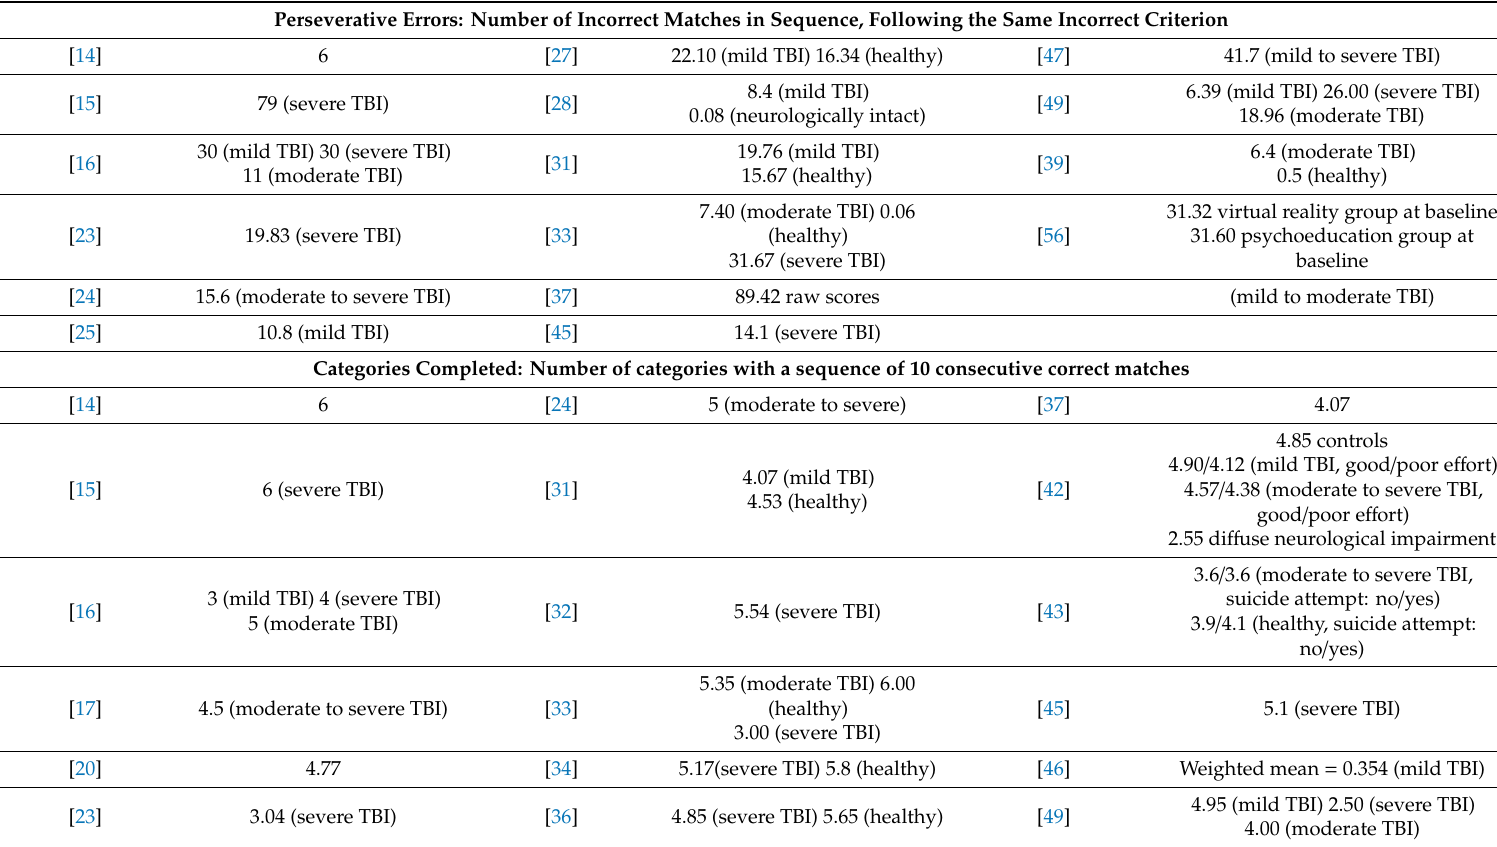
Table 4. Mean scores for Perseverative Errors and Categories Completed in Studies Using the WCST-128. Perseverative Errors: Number of Incorrect Matches in Sequence, Following the Same Incorrect